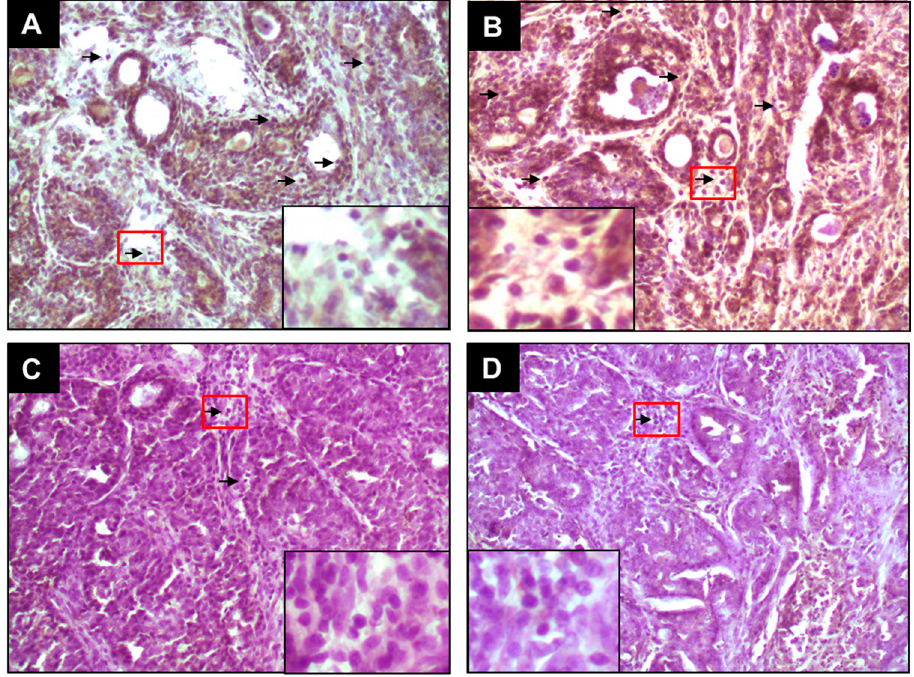
Figure 3. Effect of PE on expression of ER- β during DMBA-induced rat mammary gland tumorigenesis. The rats were treated with various oral doses of PE (three times a week) 2 weeks prior to and 16 weeks after DMBA administration. All animals were sacrificed 16 weeks post-DMBA treatment. The mammary tumors were subjected to immunohistochemical analysis using anti-ER- β antibody. Arrows indicate immunohistochemical staining of ER- β (magnification: ×200). The nuclear expression of ER- β in the designated area marked by red box is shown as an inset (magnification: ×1000) for each treatment group. Various treatment groups are: ( A ) DMBA control; ( B ) PE at 0.2 g/kg body weight plus DMBA; ( C ) PE at 1.0 g/kg body weight plus DMBA; and ( D ) PE at 5.0 g/kg body weight plus DMBA.